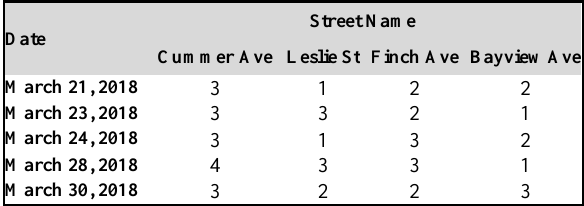
Table 2. Numbers of formed clusters for each road segment